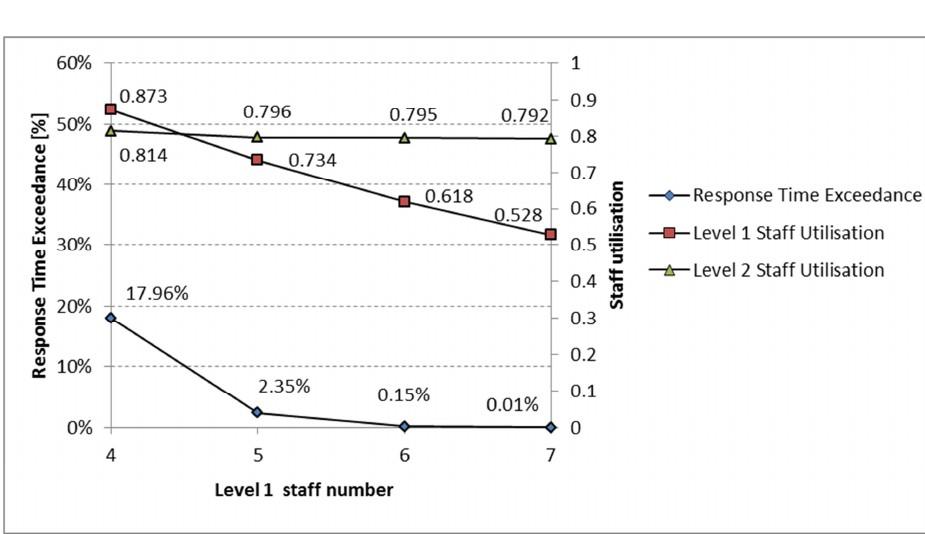
Figure 4 – Response time exceedance and staff utilisation vs. staff number for